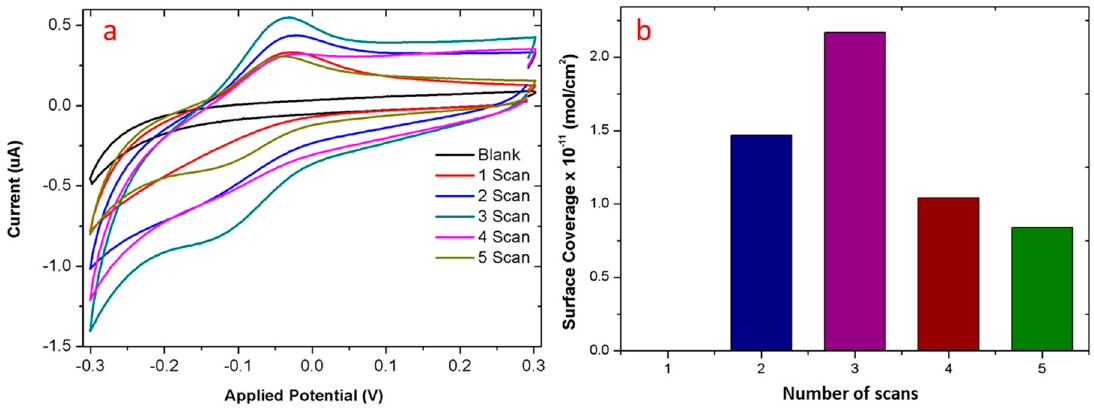
Figure 3. ( a ) Cyclic voltammograms (5 mV/s) of ferrocene carboxylic acid (FCA)-functionalisation of amine-functionalised